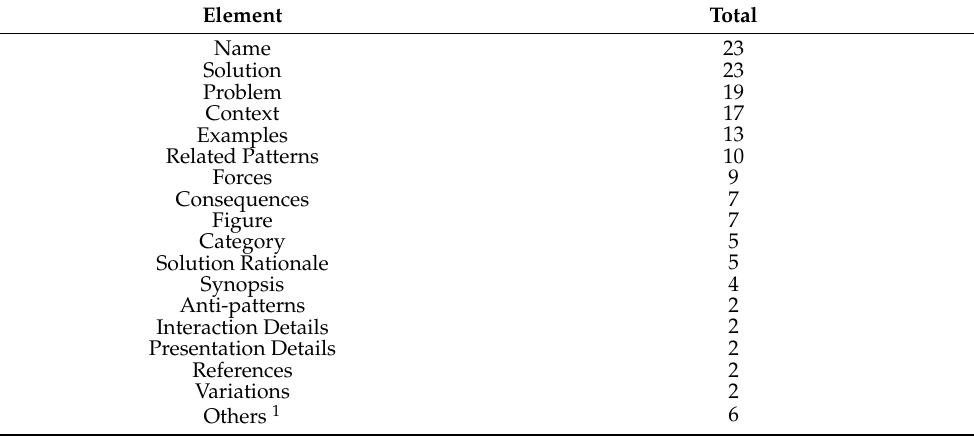
Table 25. Number of elements per the format of MUIDP. Element Total